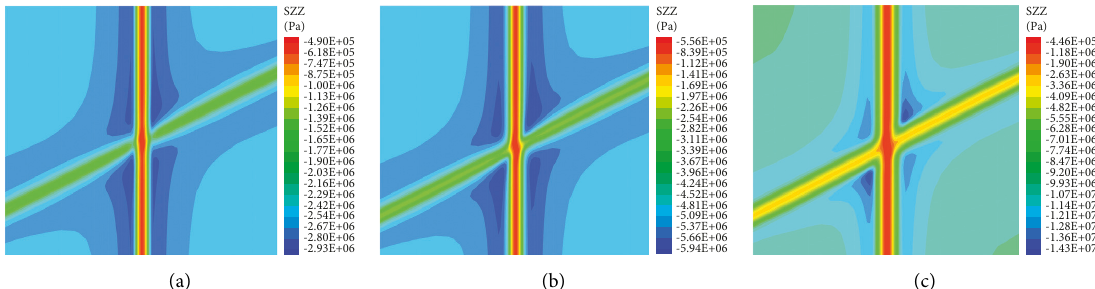
Figure 9: Disturbance influence of buried depth on surrounding rock vertical stress of staggered roadways. (a) 100m roadway buried depth, (b) 200m roadway buried depth, and (c) 400m roadway buried depth.